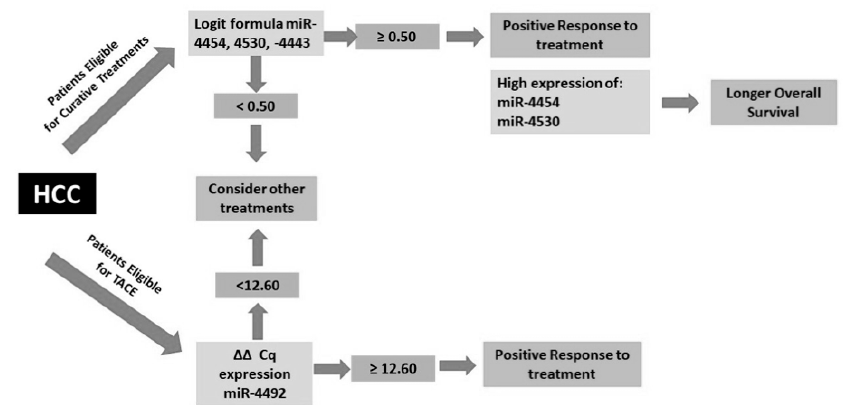
Figure 7. Schematic model to use miR-4443, -4454, -4530 and -4492 as a predictive biomarker to determine HCC treatment in patients. Logit formula value of miR-4443, -4454, and -4530 ≥ 0.50 will predict complete response to curative treatments (resection and radiofrequency ablation) and the Logit formula value of miR-4454 and miR-4530 ≥ 0.53 will predict DFS ≥ 6 months. ∆∆ Cq miR-4492 expression at a cut-o ff ≥ 12.60 will predict complete response to TACE. DFS = disease-free survival, TACE = trans-arterial